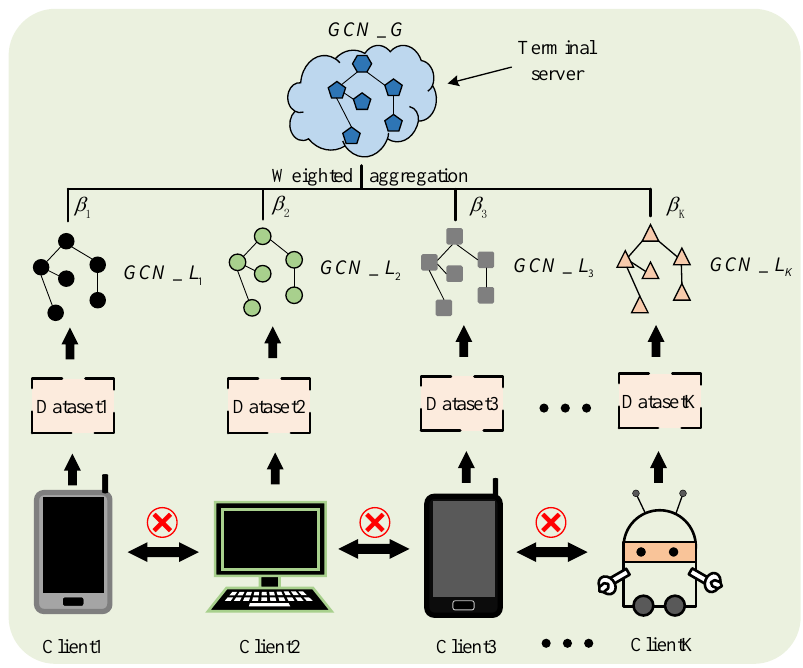
Figure 2. The federated learning framework proposed in this paper.